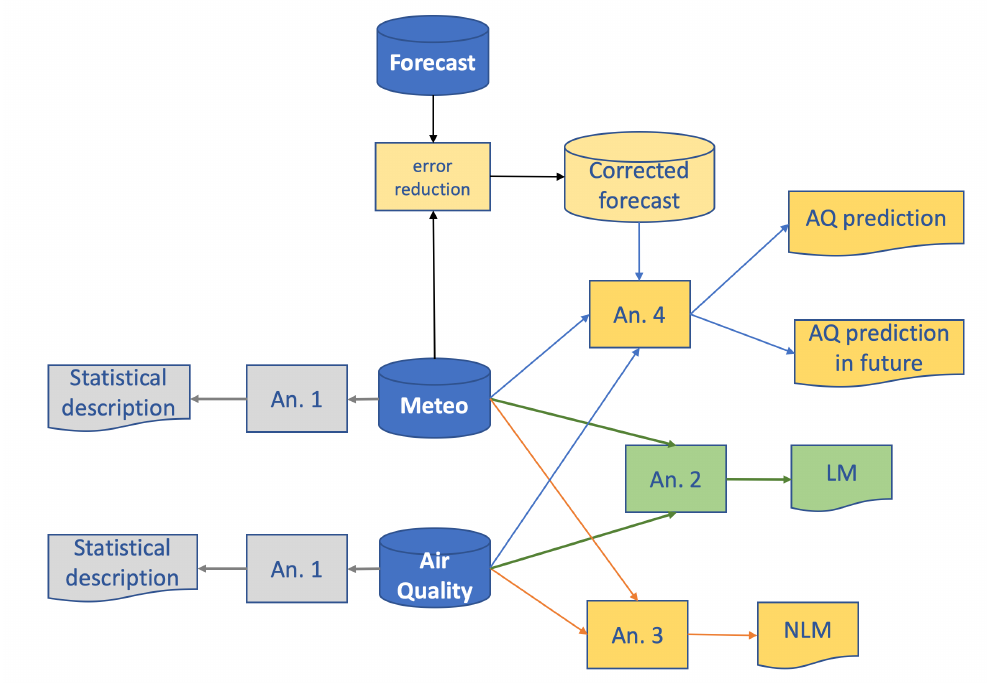
Figure 1. Overall flowchart of the proposed methodology. AQ: air quality; LM: linear model; NLM: non-linear model; An.1: step 1 of the analysis; An.2: step 2 of the analysis; An.3: step 3 of the analysis; An.4: step 4 of the